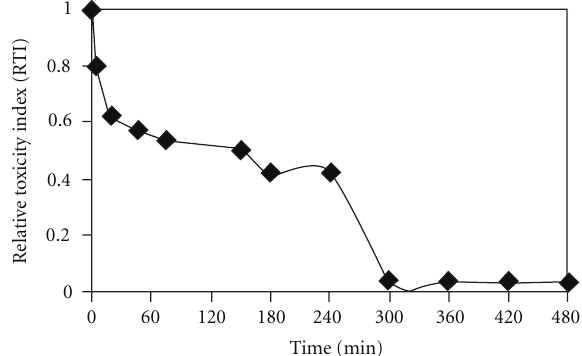
Figure 14: Variation of toxicity with time in the textile wastewater ( i = 1mA/cm 2 , Q = 36 . 3 mL/min)